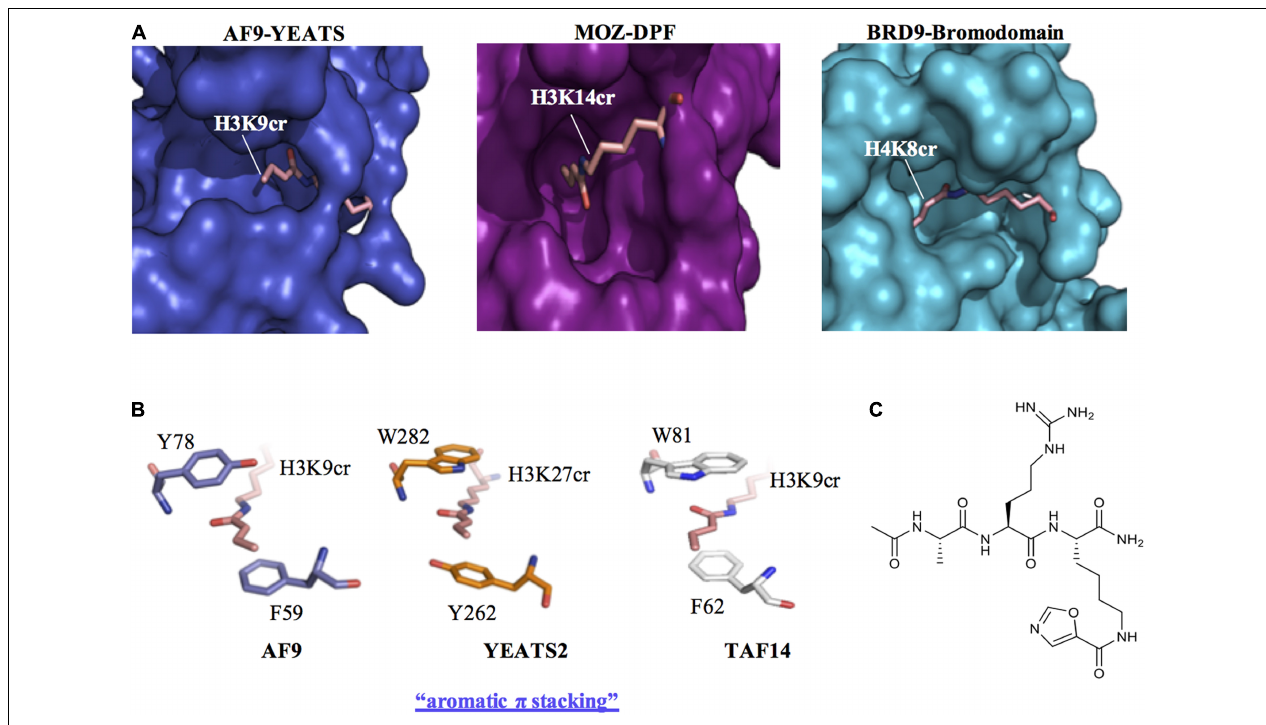
FIGURE 2 | Recognition of histone crotonylation by acyllysine readers. (A) Comparison of the binding pockets of AF9-YEATS [Protein Data Bank Identifier (PDB ID): 5HJB], MOZ-DPF (PDB ID: 5B76) and BRD9-bromodomain (PDB ID: 4YYH) reader proteins in complex with histone peptides that contain crotonyl-lysine (H3K9cr, H3K14cr, and H4K8cr, respectively). (B) Crystal structures of the YEATS domains of AF9 (PDB ID: 5HJB), YEATS2 (PDB ID: 5IQL), and TAF14 (PDB ID: 5IOK) in complex with crotonylated histone peptides reveal a conserved molecular mechanism for crotonyllysine recognition among the YEATS family members. The sandwiching of the planar crotonylamide group between two aromatic residues, which is also known as aromatic π stacking, explains the preference of the YEATS proteins for Kcr. (C) Structure of the YEATS domain selective inhibitor